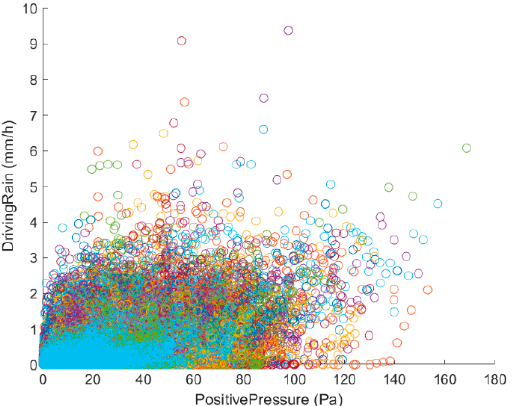
Figure 7. South facing facade 2006–2095. Hourly amount of driving rain on the facade to the expected pressure. Pressure on the facade was based on hourly climate data.